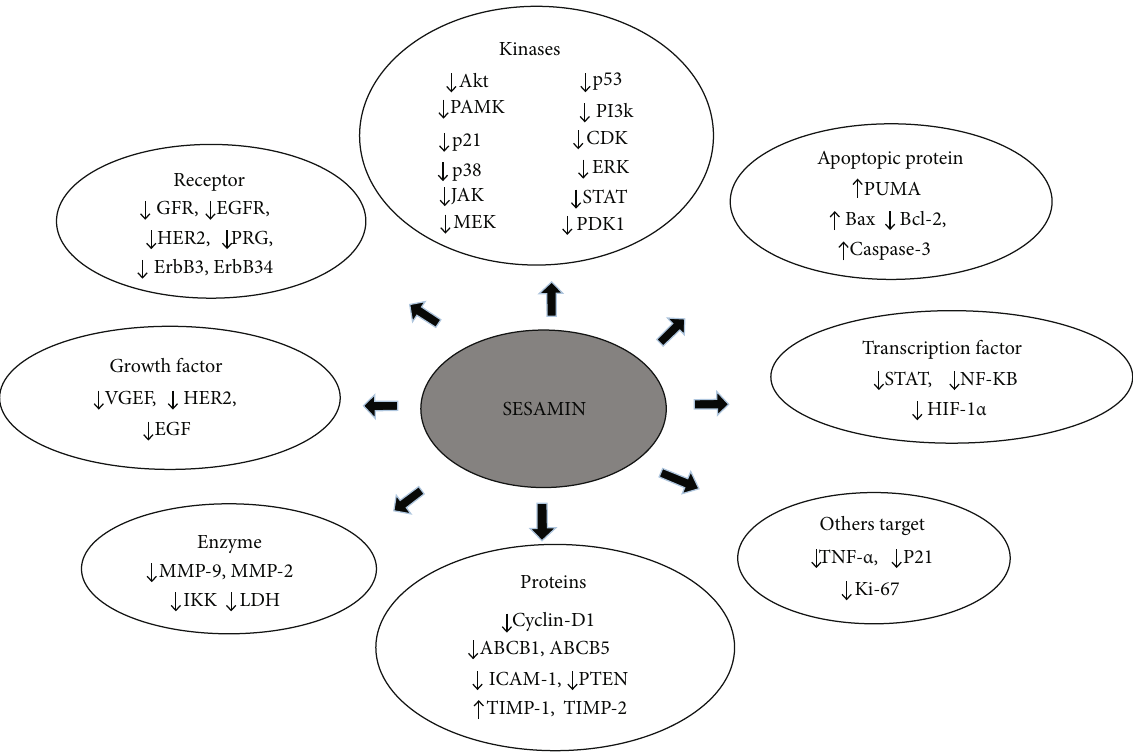
Figure 3: Overview of molecular targets in fl uenced by sesamin in breast cancer. Studies have shown that sesamin can targets major molecular factors in breast cancer treatments. Downward directions ( ↓ ) represent downregulation, while upward directions ( ↑ ) represent